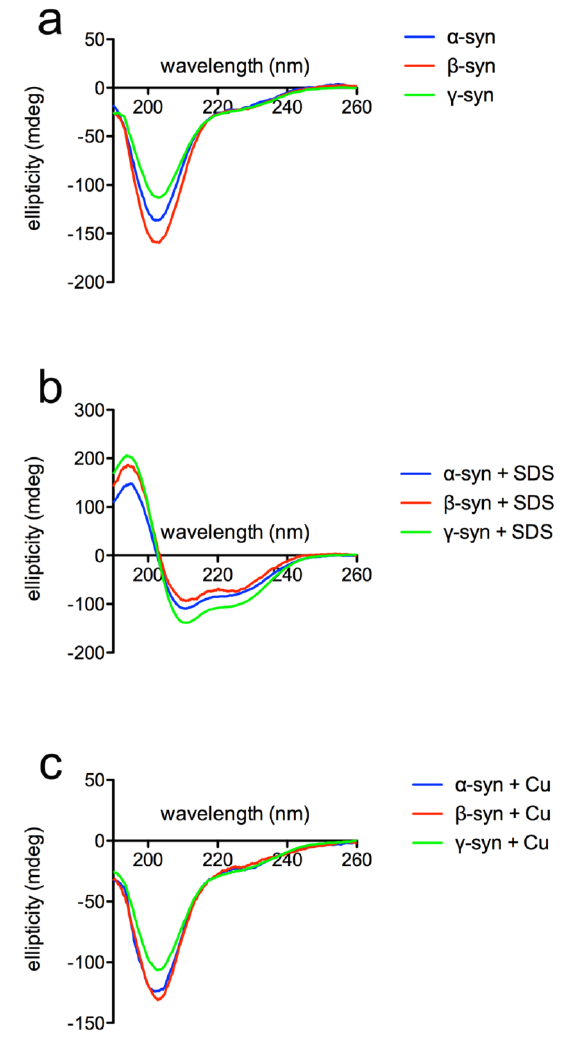
Figure 7. CD spectra of purified recombinant Xenopus syns. The proteins were diluted in 10 mM potassium phosphate buffer pH 7, containing 50 mM Na 2 SO 4 ( a ); SDS was added at 10 mM ( b ), while CuSO 4 was added at 100 µM final concentration ( c ). The spectra are normalized for protein concentration.